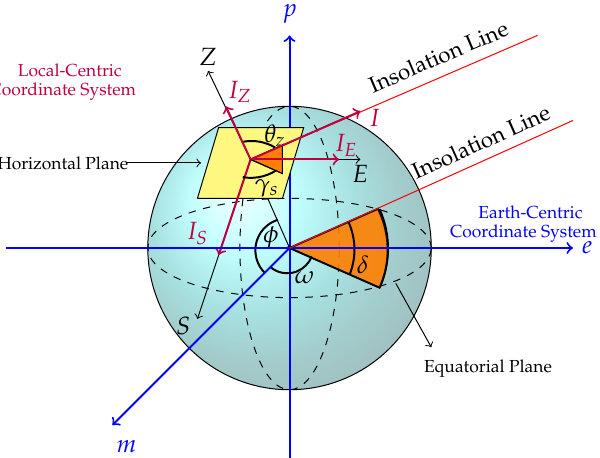
Figure 4. Representation of Vector I along the insolation line, i.e., resolved into the vectors I S , I Z , and I E